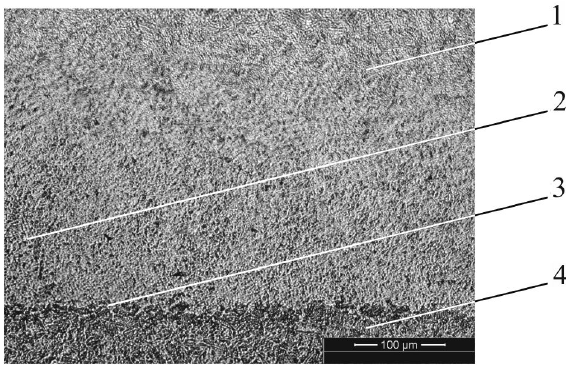
Figure 4. The structure of 40HNMA chrome–nickel–molybdenum steel in the cross section of the heat-affected zone: 1—hardened grain structure of a martensitic type; 2—area of incomplete hardening; 3—transition zone; 4—initial structure [65].